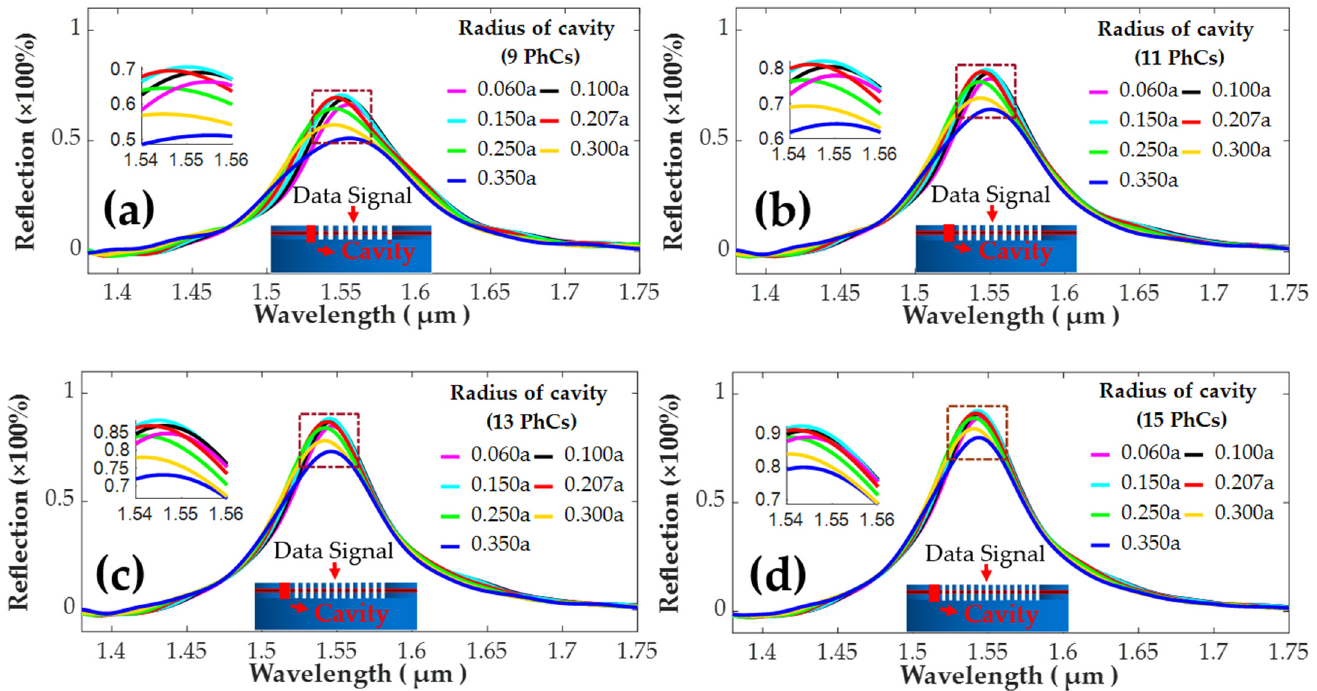
Figure 6. Effects of radius of PhC-cavity on the reflection peaks for ( a ) 9 PhC-elements ( b ) 11 PhC- elements ( c ) 13 PhC-elements ( d ) 15 PhC-elements.